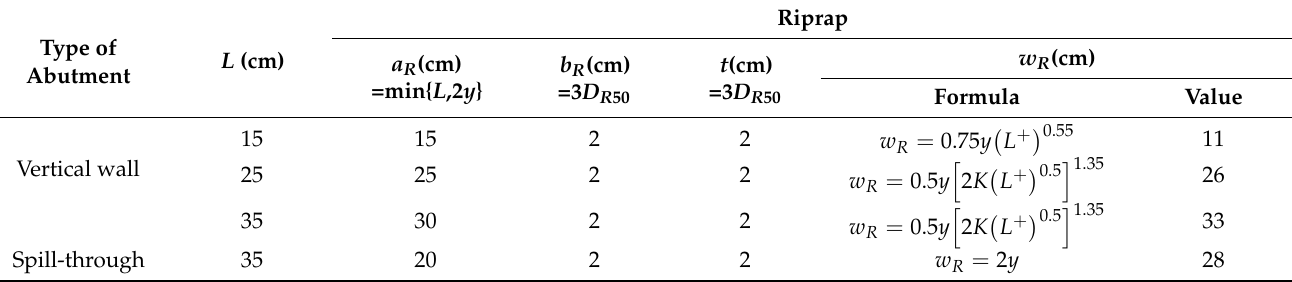
Figure 3. Scale ratios of the riprap apron and position of the maximum scour depth at the ( a ) spill-through abutment; ( b ) vertical-wall abutment.